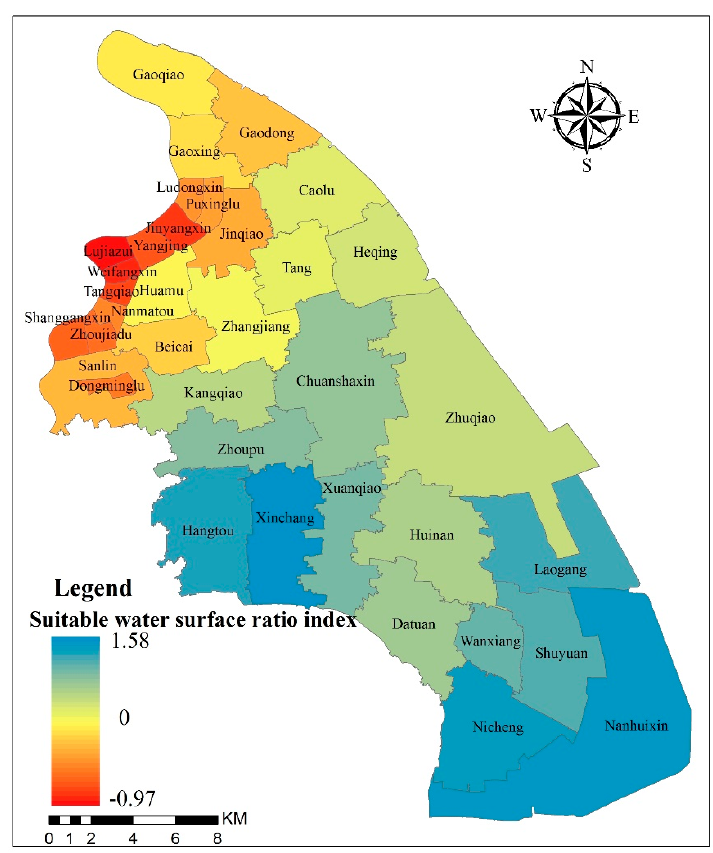
Figure 5. Suitable water surface ratio index of the Pudong New Area.